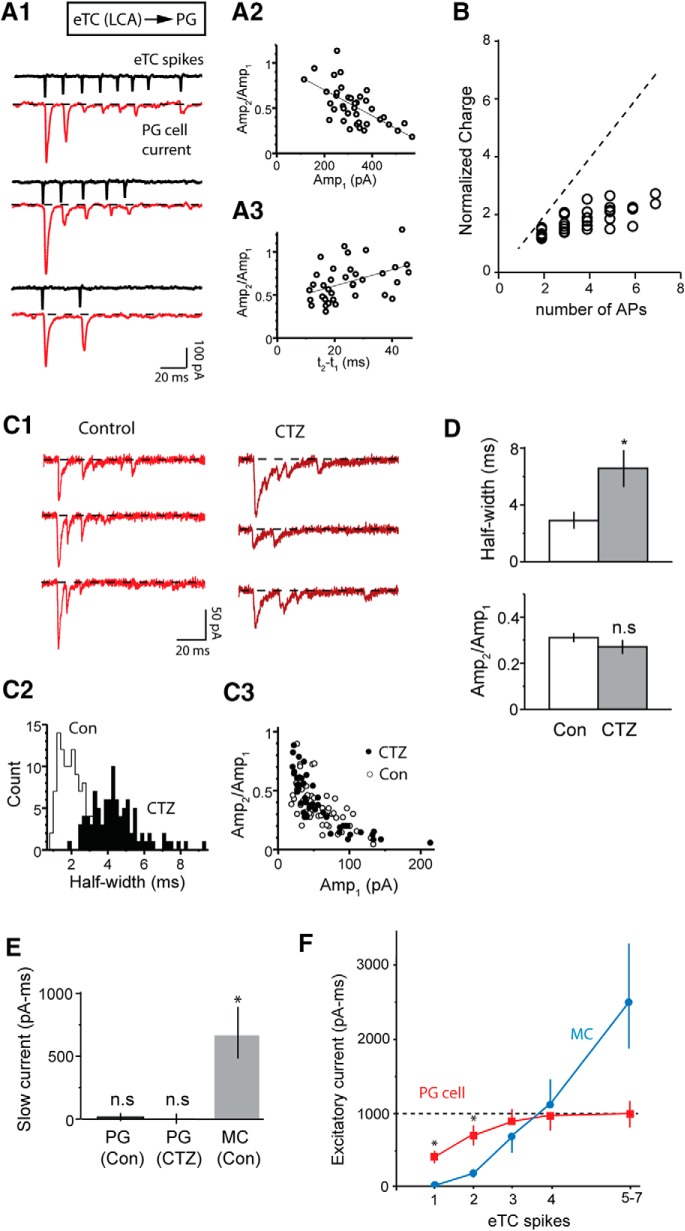
Sublinear increase in PG cell excitatory currents in eTC-PG cell pairs. A, Example recordings in an eTC-PG cell pair showing that spontaneous bursts of spikes in the eTC (recorded in LCA mode) were associated with strongly depressing rapid EPSCs in the PG cell. Three selected examples with varying number of eTC spikes are illustrated in A1. Analysis of 37 such bursts in this pair indicated that the degree of synaptic depression as reflected in the amplitude ratio of the first two EPSCs in the burst (Amp2/Amp1) was negatively correlated with the first EPSC amplitude (r = –0.63, p < 0.0001; A2) and positively correlated with the interval between the first two EPSCs (r = 0.44, p = 0.0058; A3). Both are consistent with a presynaptic vesicle depletion mechanism for depression. B, Summary of integrated current measurements from 10 eTC-PG cell pair recordings, demonstrating that the synaptic depression resulted in a sublinear increase in the excitatory current as a function of spike number in the eTC. Diagonal line reflects linearity. C, Example PG cell recording showing that the AMPA receptor allosteric modulator CTZ (100 µM) prolonged the EPSCs without altering the degree of depression. Selected EPSC bursts under each condition are illustrated in C1, while EPSC half-widths (C2) and amplitude ratios (Amp2/Amp1; C3) for the same experiment are also shown. The absence of an effect of CTZ on depression supported a presynaptic mechanism. D, Histograms summarizing CTZ effects on EPSC half-width (top) and the Amp2/Amp1 ratio (bottom) from five PG cell recordings; *p = 0.020 in paired t test. E, Estimates of the magnitude of slow currents in PG cells not directly associated with rapid EPSCs. PG cell currents, both under control conditions and in CTZ, were measured in a 100- to 200-ms window after the start of each eTC spike burst for bursts with more than or equal to four spikes lasting <100 ms. MC currents (reflecting Iextra) measured in the same manner are also plotted; n = 5 for each recording type; *p < 0.01 in paired t test comparison with zero current. F, Summary of absolute charge measurements as a function of eTC spike number for Iextra in MCs in the eTC-MC pairs (blue) and the PG cell current in the eTC-PG cell pairs (red). Each data point reflects mean ± SEM from 7–10 recordings; *p < 0.01 in Mann–Whitney U test, Bonferroni correction for multiple comparisons.